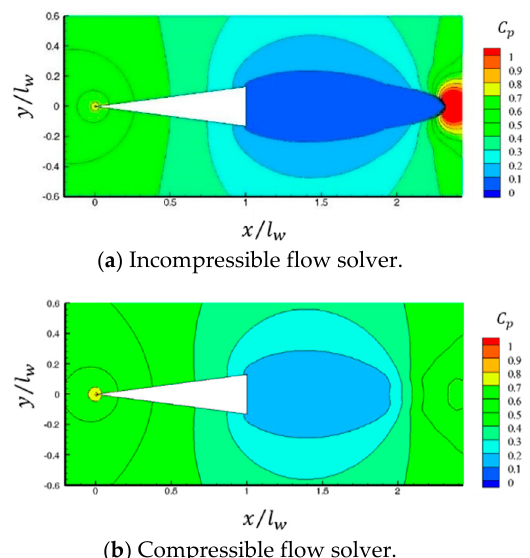
Figure 10. Pressure coefficient contours around wedge at σ = 0.35.